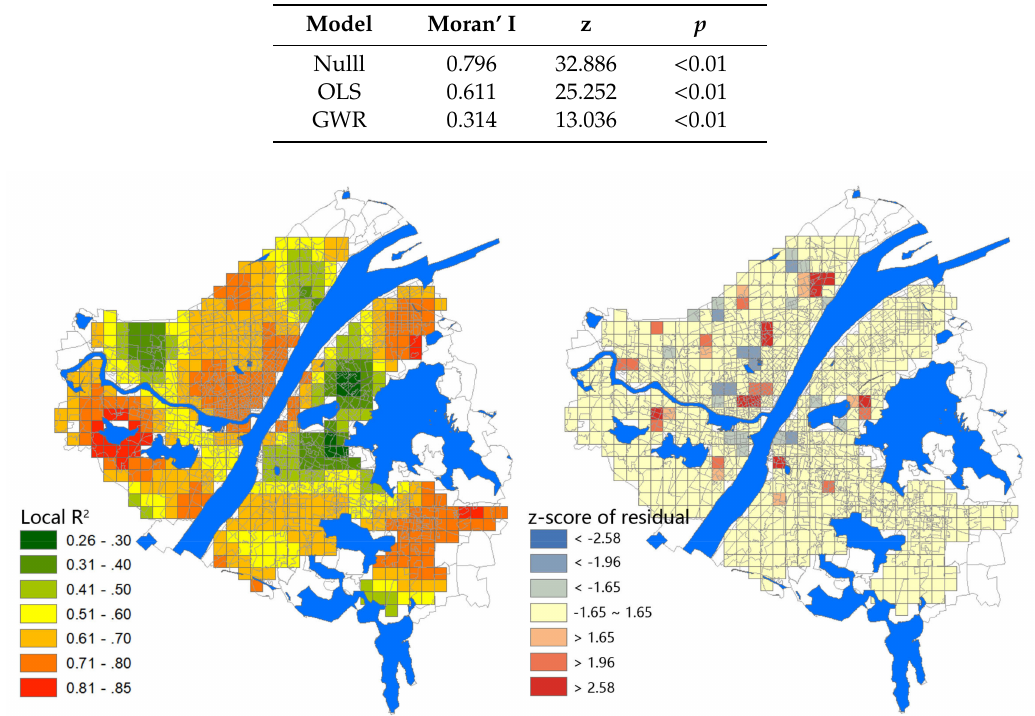
Figure 6. The local R2 value of the geographically weighted regression (GWR) model and the residual standard deviation with